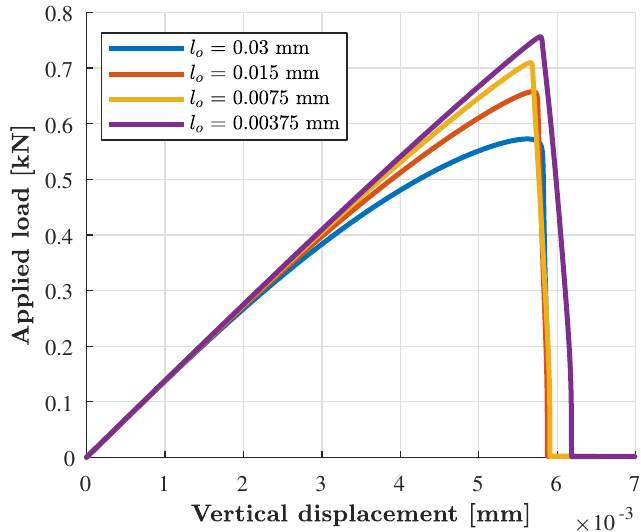
Figure 15. Tension test effect of length-scale parameter variation on load displacement curves.